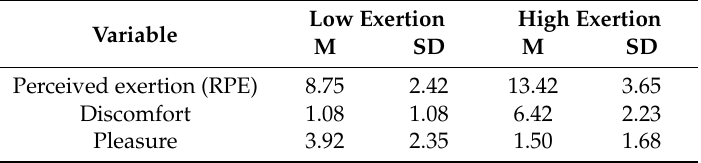
Table 3. Means and Standard Deviations of Perceived Exertion, Discomfort, and Pleasure under Conditions of Low Exertion and High Exertion in Experiment 4.